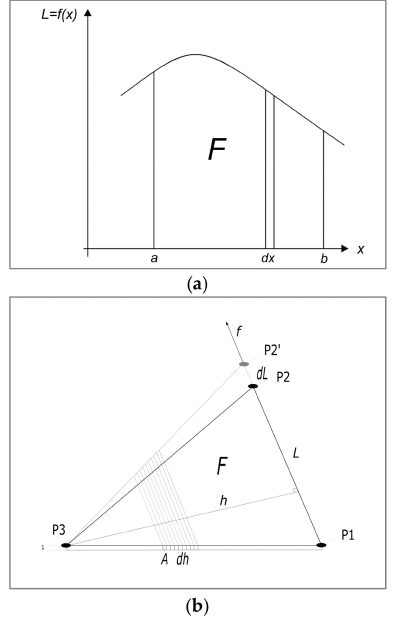
Figure 1. Deformation energy W F at a surface strain in L -direction ( a ) and decomposition of a surface into di ff erentially narrow bars interrelating with the triangle and the points ( b